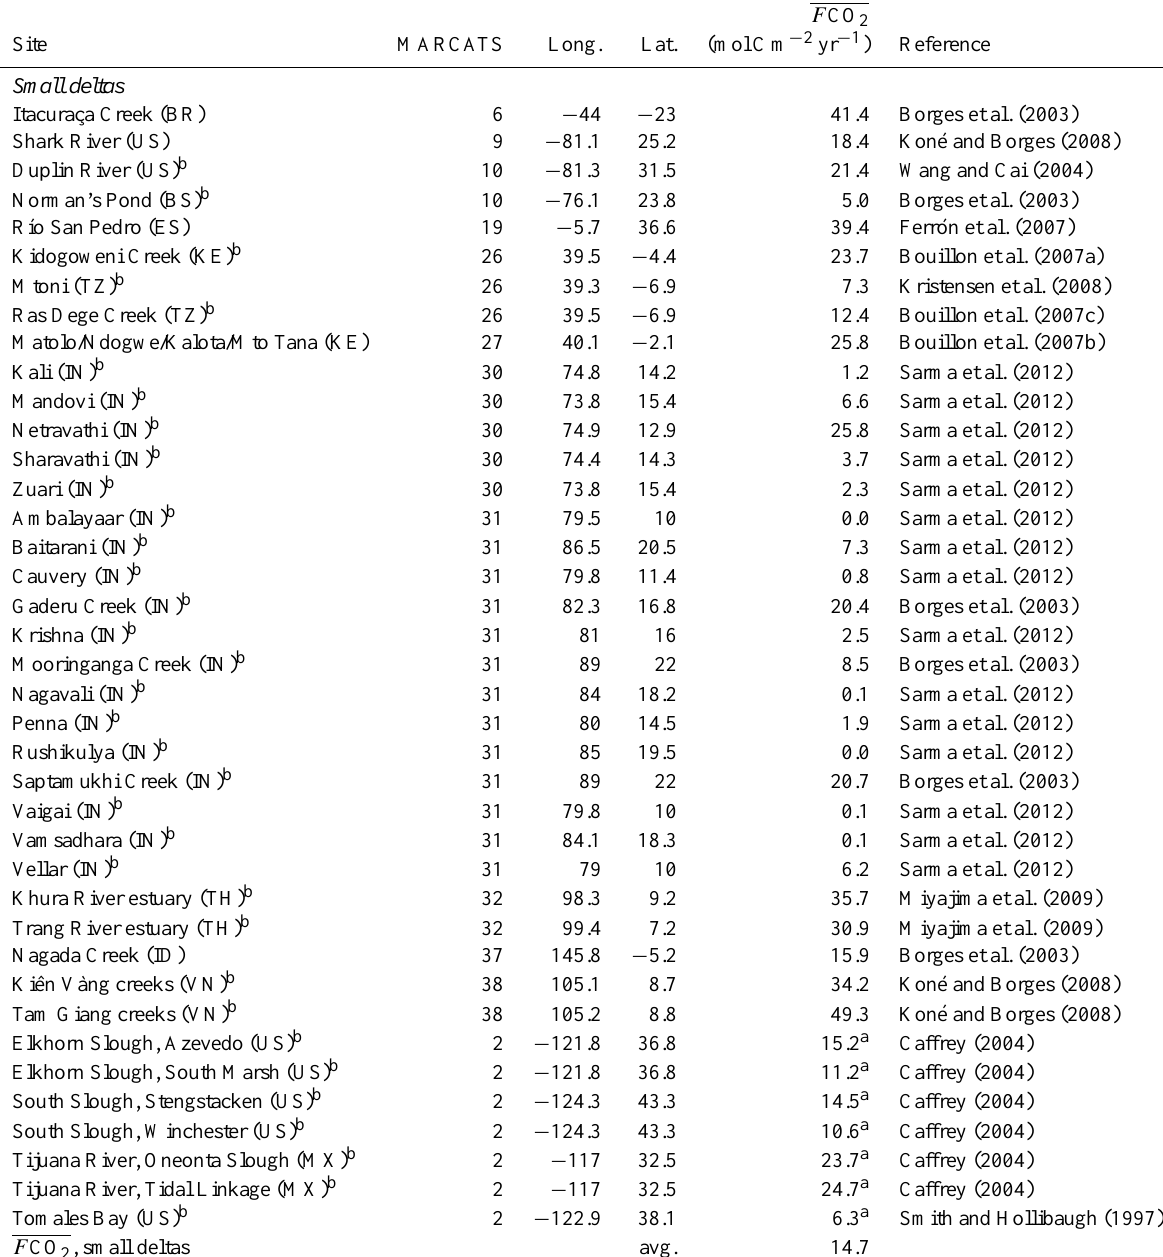
Table 5. Air–water CO 2 fluxes for each estuarine type based on field studies. Positive values represent a source of CO 2 to the atmosphere. a indicates a CO 2 rate calculated from a NEM estimate and b indicates sites used to derive regional averages. Global emissions per unit surface area based on direct F CO 2 and derived from NEM lead to similar results for small